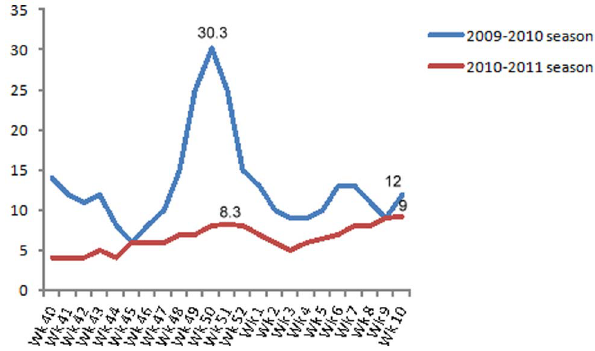
Figure 3. Percentage of consultant in sentinel centre during 2009–2010 and